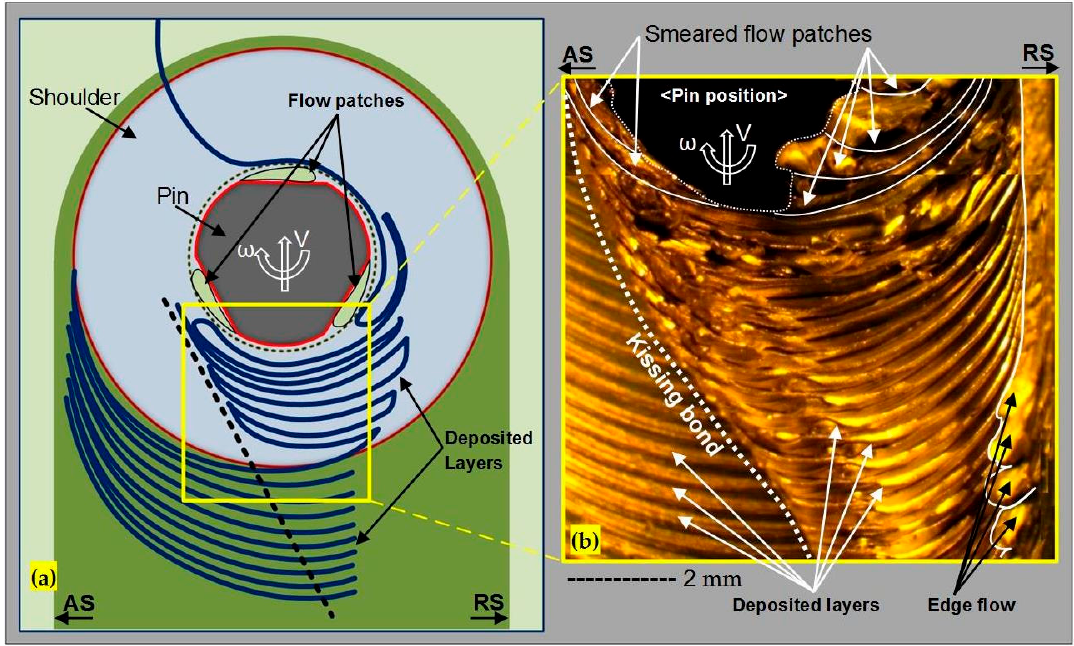
Figure 12. The top view of the sub-shoulder region with a proposed model for the flow-lines 0.5 mm underneath the shoulder during the stirring action. ( a ) the flow model of the sub-shoulder area, ( b ) the macro-etched sub-shoulder region including the actual flow patterns, at the position of the exit zone.